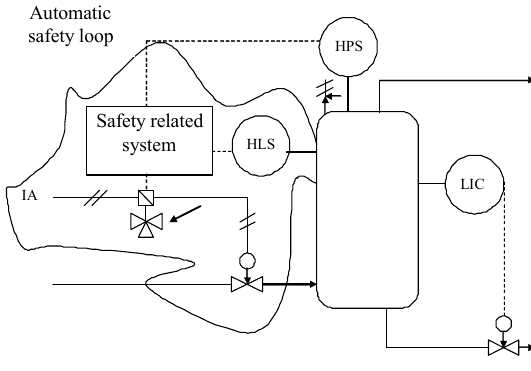
Figure 16. P&ID of a high-pressure tank.